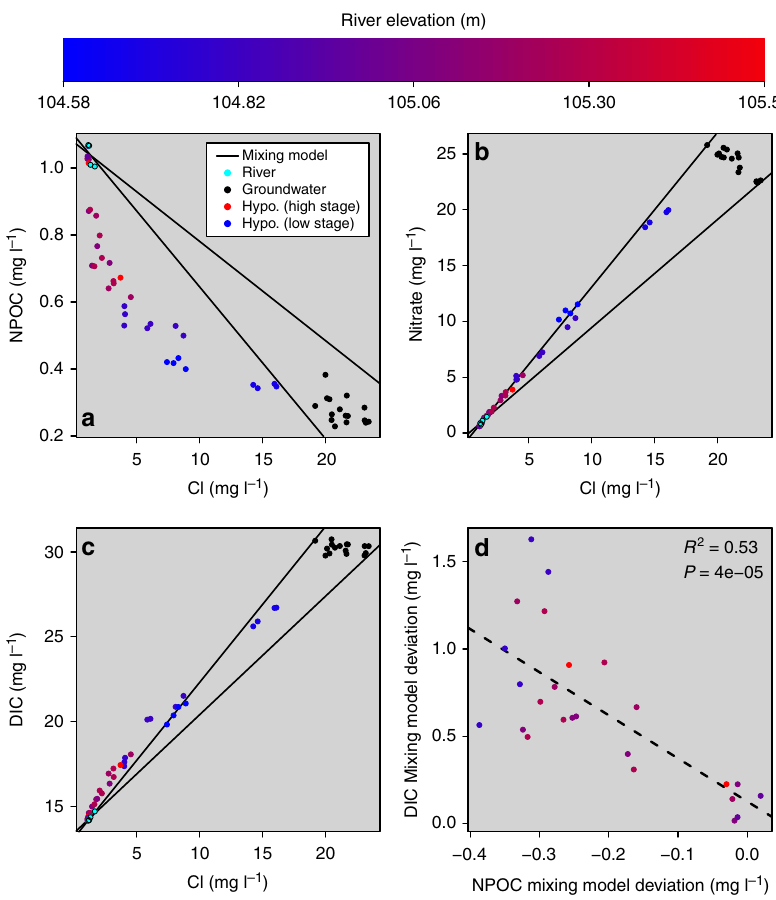
Figure 3 | Solutes and associated mixing models. ( a – c ) Dissolved solutes as a function Cl (cid:2) concentration with mixing model expectations indicated by solid lines. DIC, dissolved inorganic carbon; NPOC, non-purgable organic carbon. ( d ) Deviation from the upper/steeper DIC mixing model as a function of the deviation from the lower/steeper NPOC mixing model. To focus on positive DIC deviations, data points were restricted to Cl (cid:2) o 7mgl (cid:2) 1 . Linear model (dashed line) statistics are provided. In all panels, river stage at the time of sample collection in the hyporheic zone is indicated by a gradient from blue (low river stage) to red (high river stage); values corresponding to colours are provided in the colour